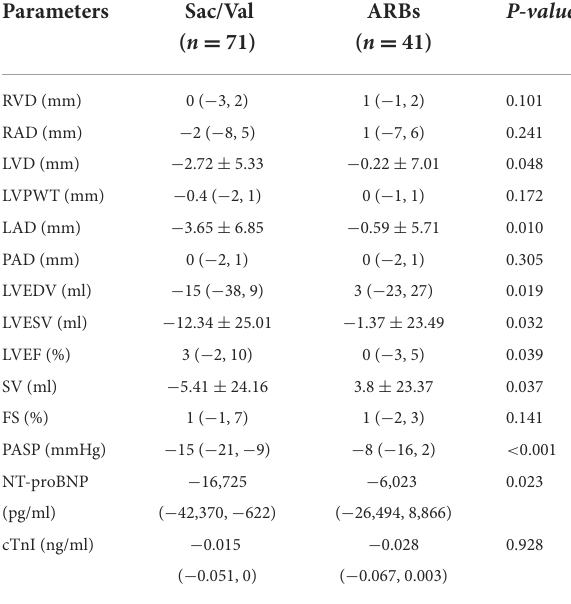
TABLE 4 Changes of echocardiographic parameters and cardiac biomarkers in two groups.